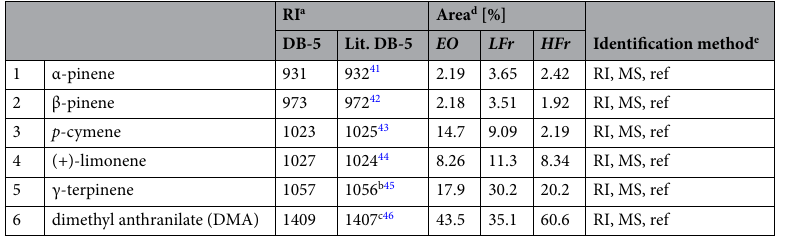
Table 2. The main constituents of the petitgrain mandarin ( Citrus reticulata blanco var. Mandarin) oils. a Experimental and literature RIs relative to n -alkanes on a DB-5 capillary column unless otherwise stated. b RI for the DB-5MS column. c RI for the SLB-5MS column. d Area percentages of the main components; EO essential oil, LFr a light fraction of the oil, HFr a heavy fraction of the oil. e Methods: RI identification based on RI comparison with literature data, MS identification based on mass spectra comparison with those of the Wiley Registry of Mass Spectral Data library (8th edition) and the Adams library of essential oil components (edition 4.1), ref. coinjection with an authentic